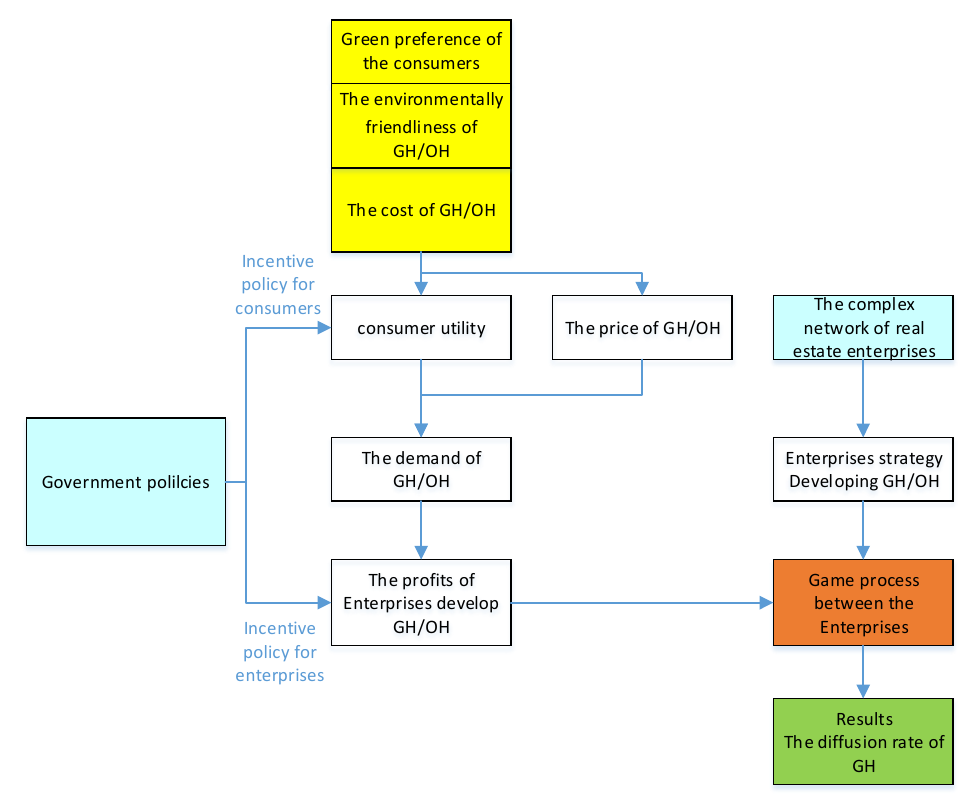
Figure 1. Analytic framework.